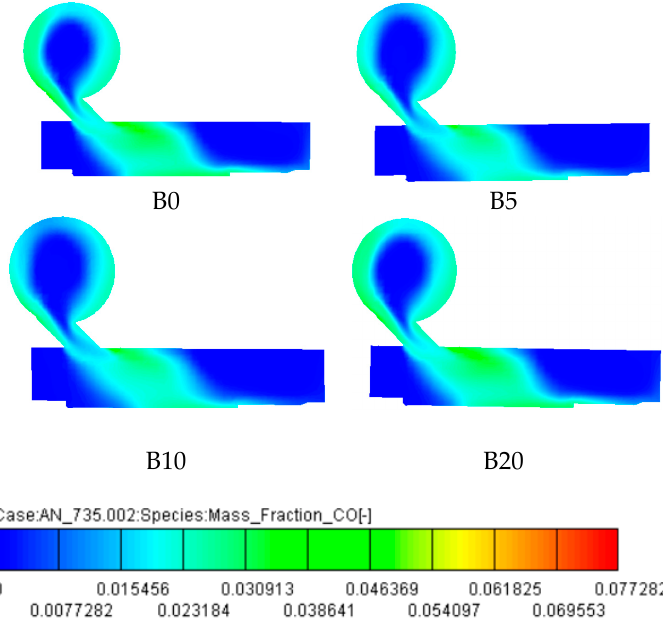
Figure 17. The progress of CO at 39° ATDC at 1400 rpm and 100% load.